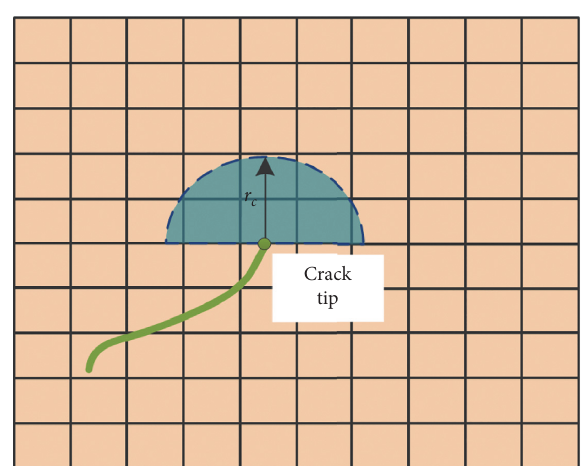
Figure 3: Illustration of nonlocal averaging of the stress around the crack